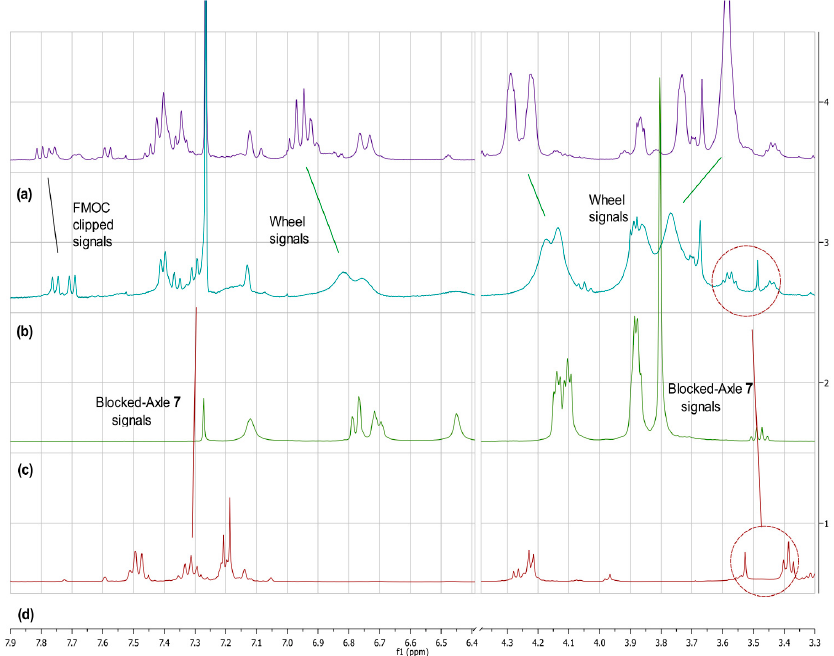
Figure 3. Example of the disassemblage of FMOC-R 1 caused by the presence of piperidine. ( a ) FMOC-R 1 (2 mM) in CDCl 3 /DMSO- d 6 (95%/5% v / v ); ( b ) the same solution as ( a ) with the addition of piperidine